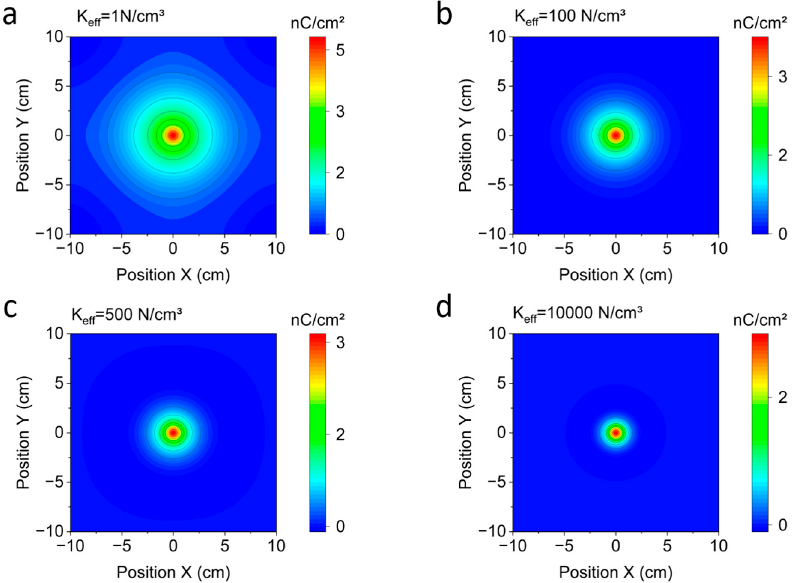
Figure 8. Stress-induced polarization (z-component) in the piezoelectric layer for different effective stiffness values of the underlayment layer, with K eff of ( a ) 1 N/cm 3 , ( b ) 100 N/cm 3 , ( c ) 500 N/cm 3 , and ( d ) 10,000 N/cm 3 . In all cases, a force of 90 N is applied on the top boundary of the floor tile layer.